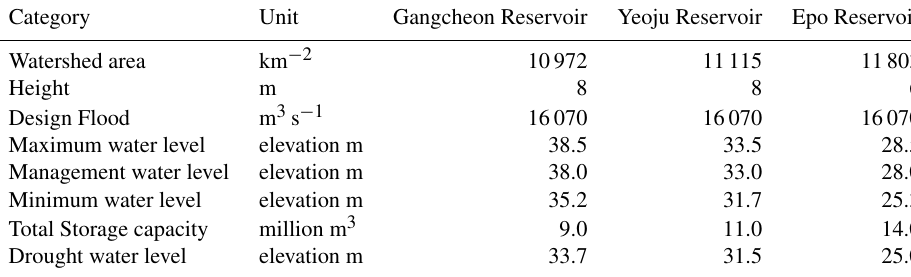
Table 3. Current status of weirs in the Han River